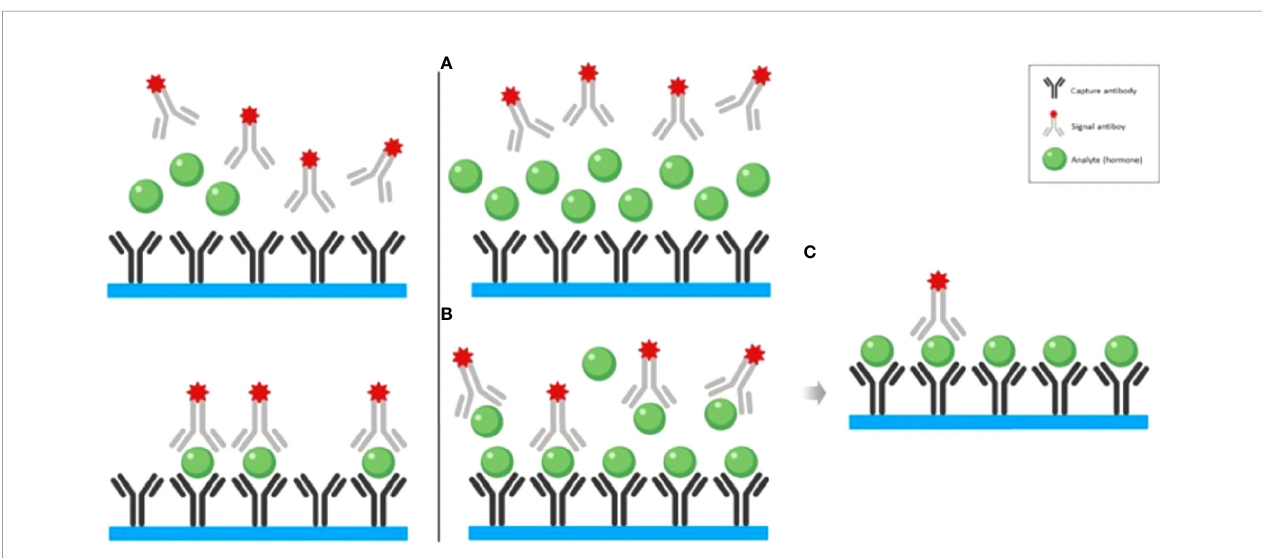
FIGURE 1 | The left panel illustrates the non-competitive “ sandwich ” immunoassay with normal (or elevated within the tolerance of the assay kit) hormone concentration. The right panel illustrates the mechanism of the hook effect with exceedingly high hormone concentration. (A) At the sample that contains remarkably elevated hormone concentration is added to the test tube which contains both capture and signal antibodies. (B) It is both the capture and signal antibodies preventing the formation of the “ sandwiches ” . (C) After the washout phase, only a few “ sandwiches ” will be left producing a low signal. Adapted from Haddad et al. Clinical Diabetes and Endocrinology (2019) 5:12 (3) with previous authorization from the author